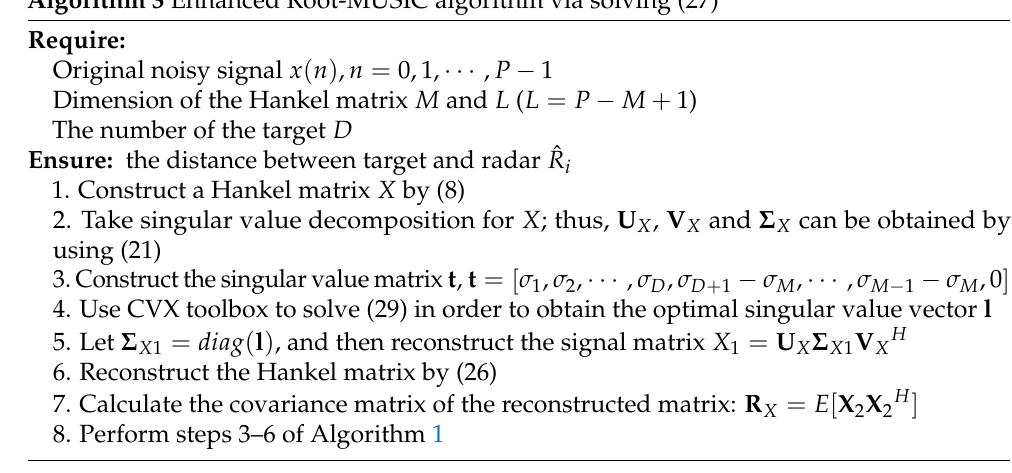
Algorithm 3 Enhanced Root-MUSIC algorithm via solving